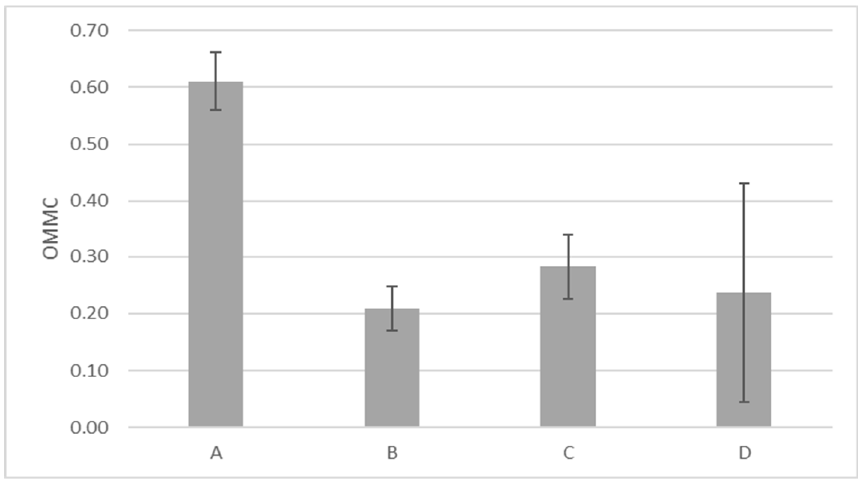
Figure 2. The test result of fabrics’ moisture management capability. Table 2. Mean values (±SD) of moisture management parameters assessed by Moisture Management Tester (MMT) for fabrics A–D.